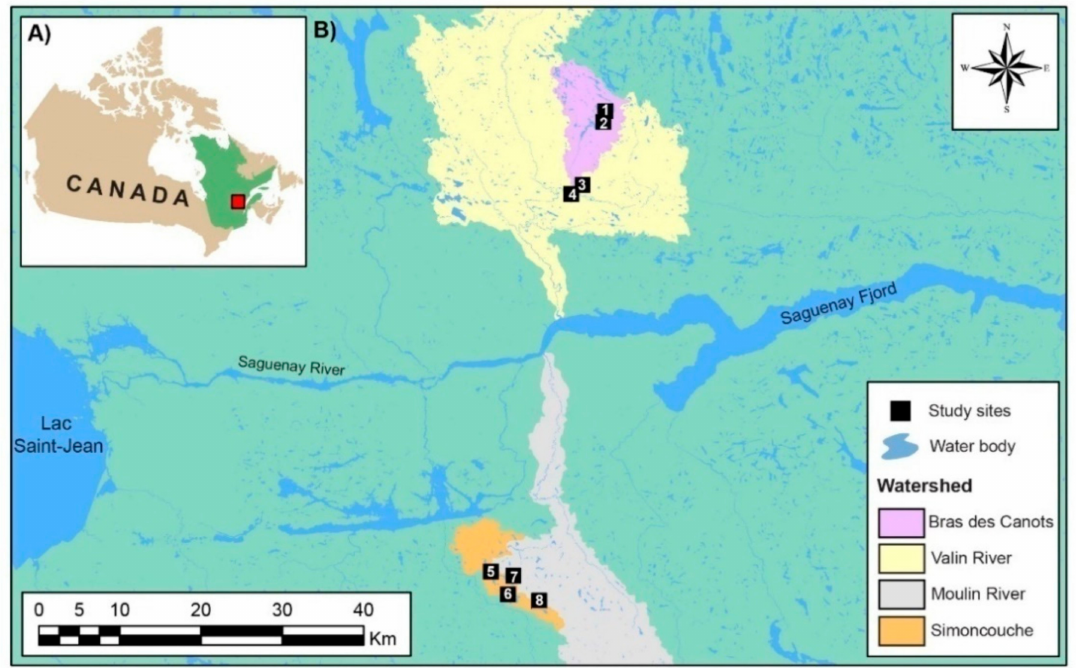
Figure 1. ( A ) Location of the study areas in North America, and ( B ) the experimental sites (1 = Martin-Valin, 2 = Culotte, 3 = Des P è res, 4 = Valin River, 5 = Simoncouche, 6 = Des Îlets, 7 = Fl é vy, 8 =